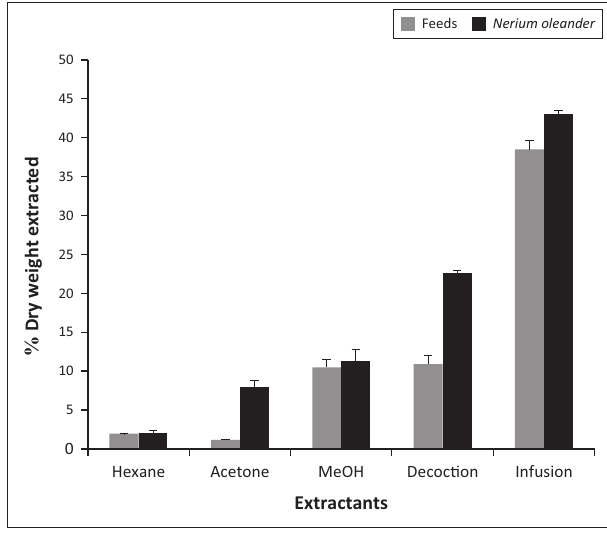
FIGURE 1: Efficiencies of organic sequential and aqueous solvent extraction systems in animal feed and Nerium oleander